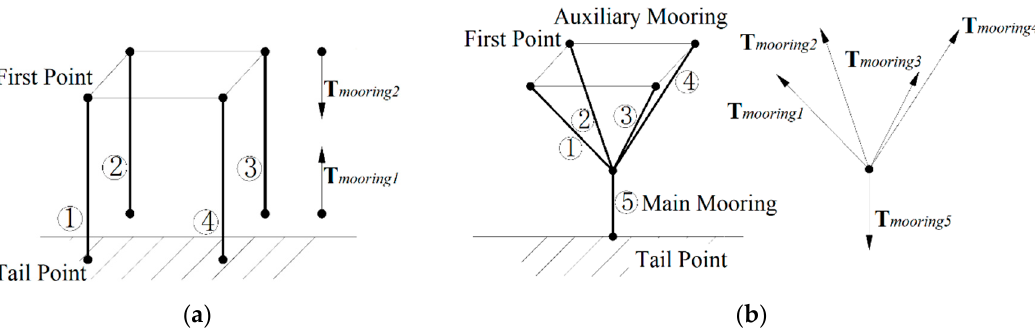
Figure 3. Calculation method of the two patterns of mooring. ( a ) Mooring mode and tension of four mooring rope. ( b ) Mooring mode and tension of four mooring rope of the auxiliary mooring rope matched with a main mooring rope.